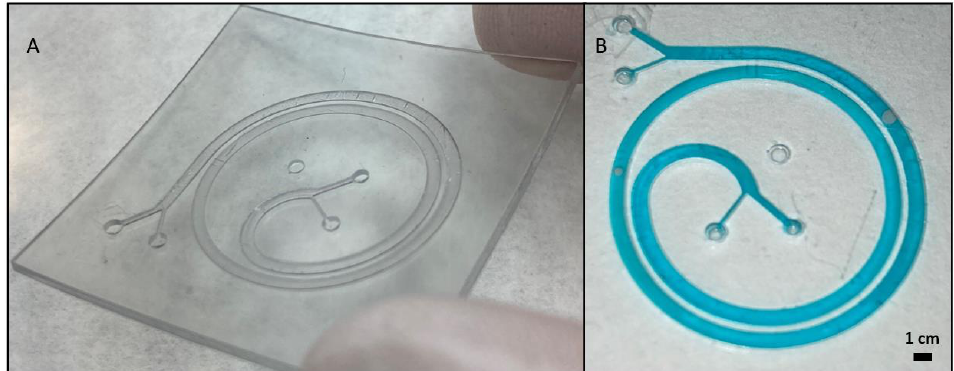
Figure 12. ( A ) Microfluidic chip printed in one single process. 3D printed result with Detax resin of the spiral, with a designed channel width of 1 mm and height of 600 µm. Only one layer of 100 µm has been printed on top of the channel to not obstruct the channel. ( B ) Test that shows there is no leakage with water tinted with blue colorant.